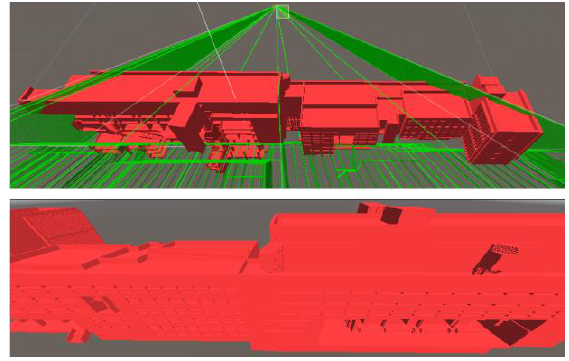
from a camera point of view (Figure 4).